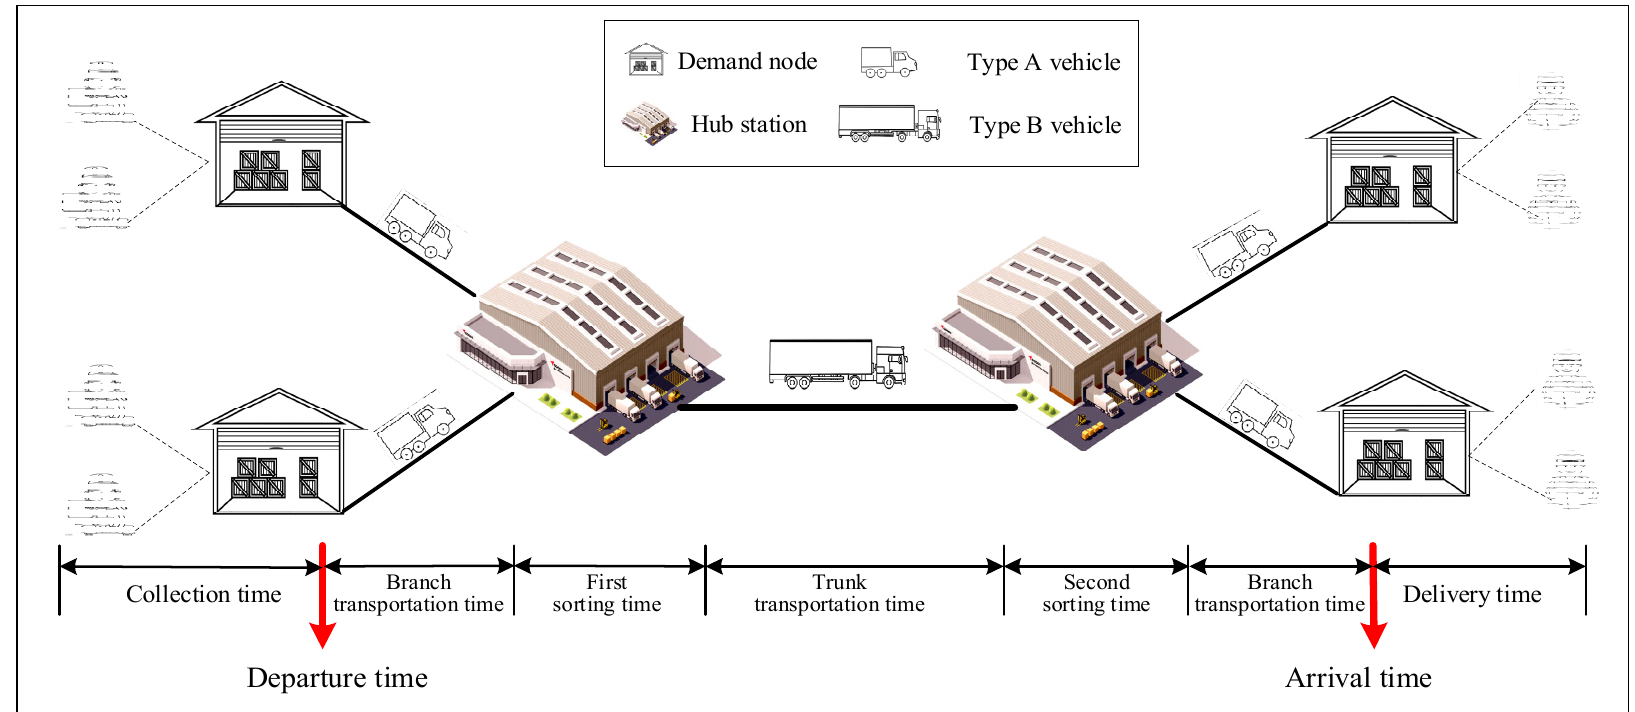
Fig. 3. The business process of the express logistics